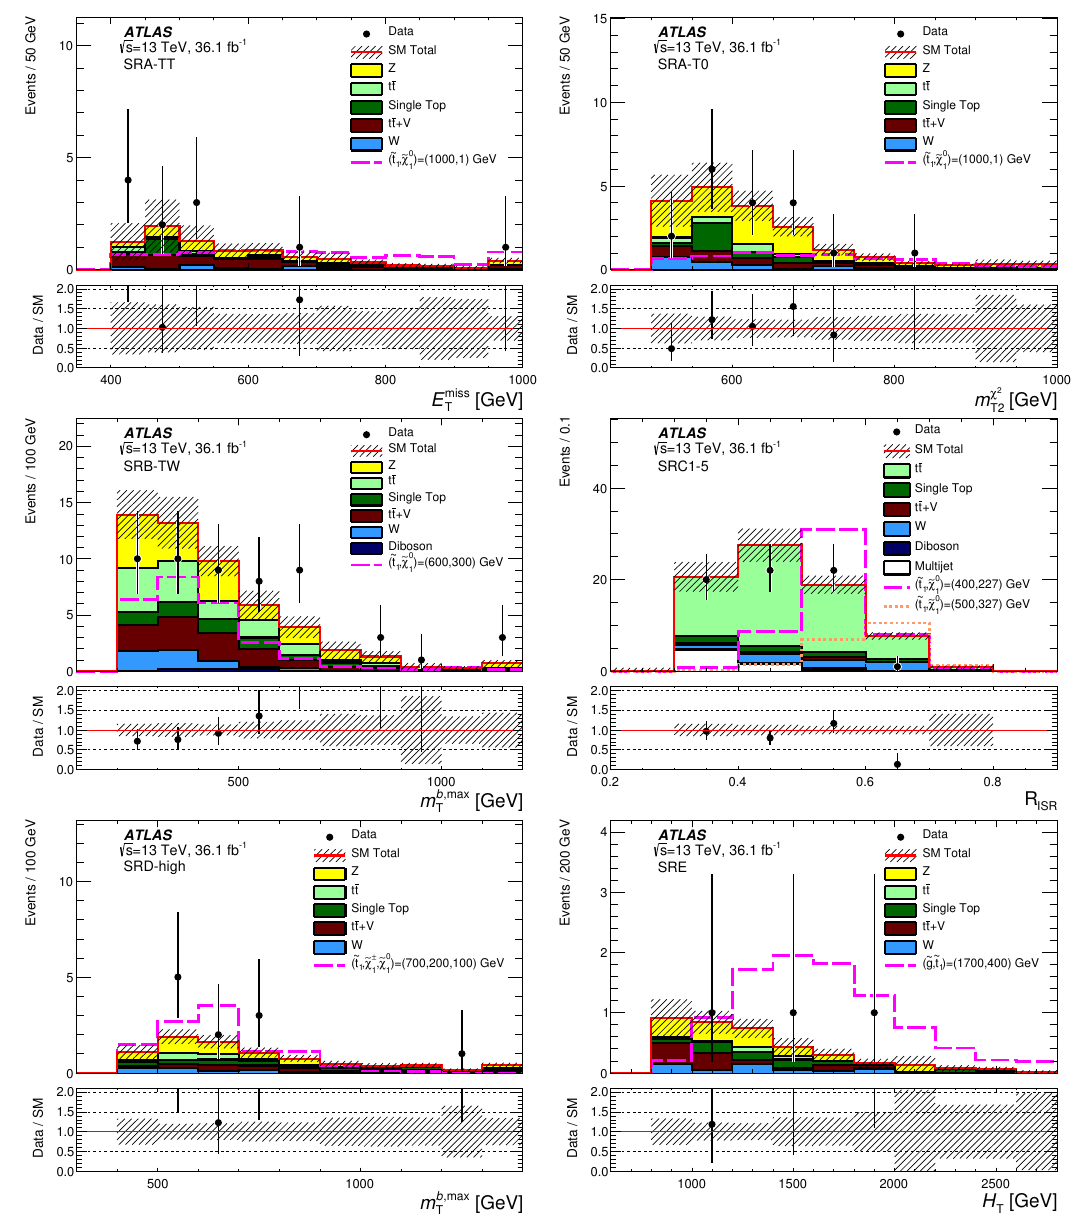
2 for SRA-T0, m b; max T2